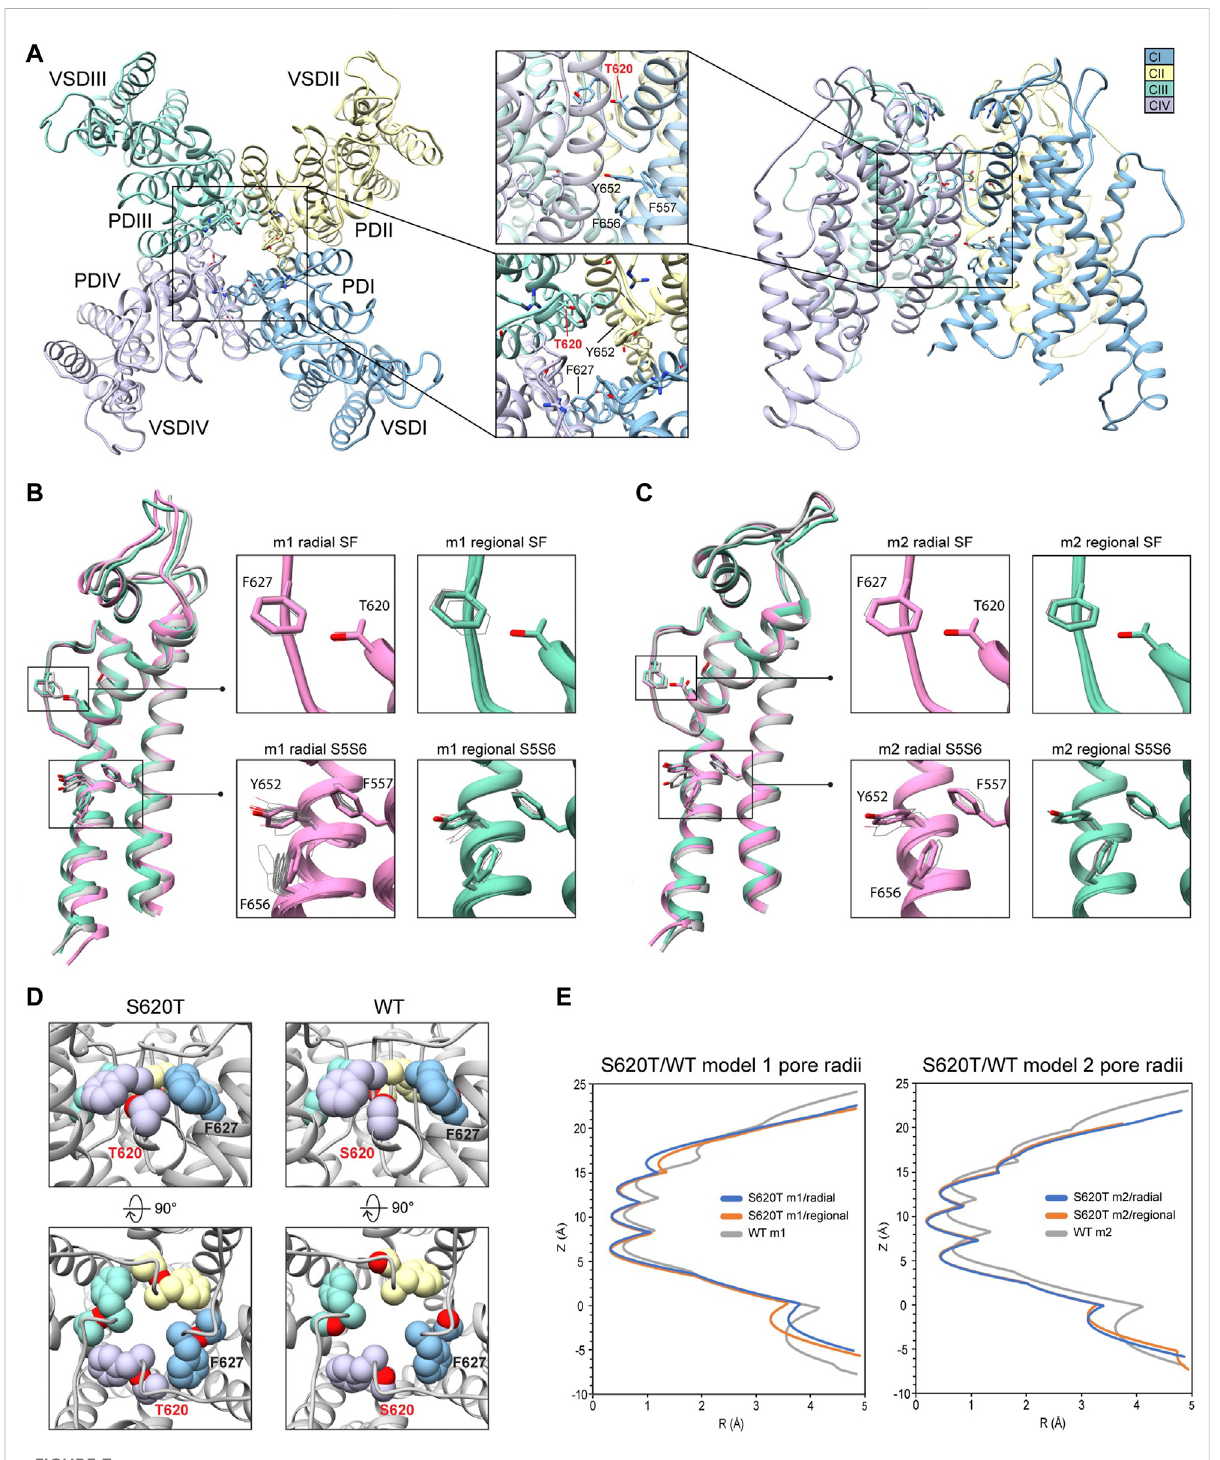
FIGURE 7 hERG S620T model 1 (m1) and model 2 (m2) comparison. (A) Domain structure of hERG S620T. Chains are colored according to legend. PD, poredomain;VSD,voltagesensingdomain.ChainIiscoloredinblue,chainIIiscoloredinyellow, chainIIIiscoloredingreen,andchainIViscolored in violet. (B) Overlay of hERG S620T m1 models using the radial (rad, pink) and regional (reg, green) movemaps. WT model structure is in gray. Single domain overlay shows top-scoring structures,whereas inset details show top50structures.Top structure ininset detail isshown assticks,with remaining shown as gray wires. Mutant residue is labeled in bold red. (C) Overlay of hERG S620T m2 models using the radial (rad, pink) and regional (reg,green)movemaps.Depictionsareidenticalto (B)(D) Comparisonofresidue620(labeledboldred)andassociatedresiduepositionssurrounding the SF in hERG WT and S620T models. Top row: detailed side-view of residue 620 interactions, bottom row: top view of hERG channel pore. Residues are shown as spheres and colored according to their respective chains (see legend in (A) and Figure 2). (E) Pore radii, R , pro fi les along the z axis are generated by the HOLE program for hERG S620T m1 radial (blue) and regional (orange), WT m1 (gray)